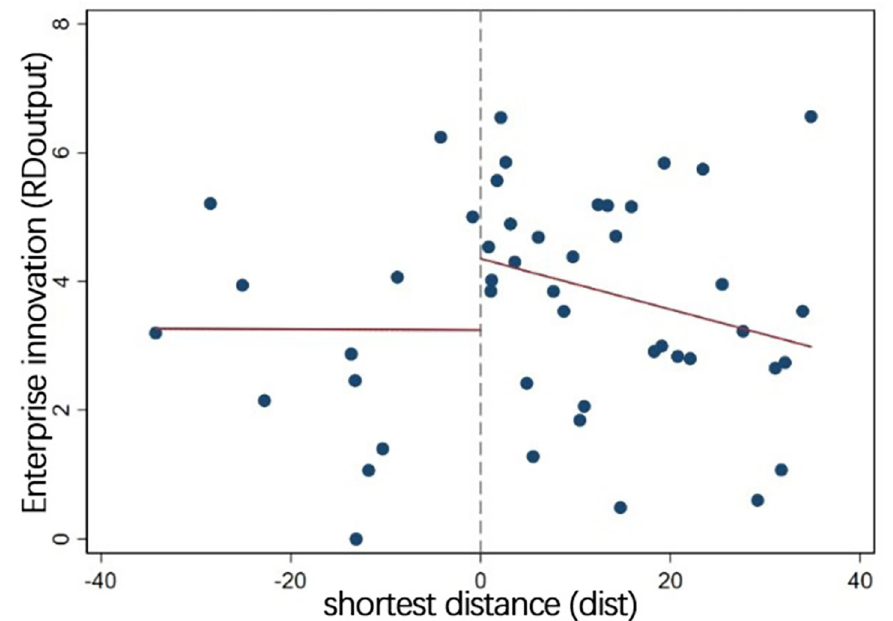
Fig 3. Changes of enterprise innovation at the